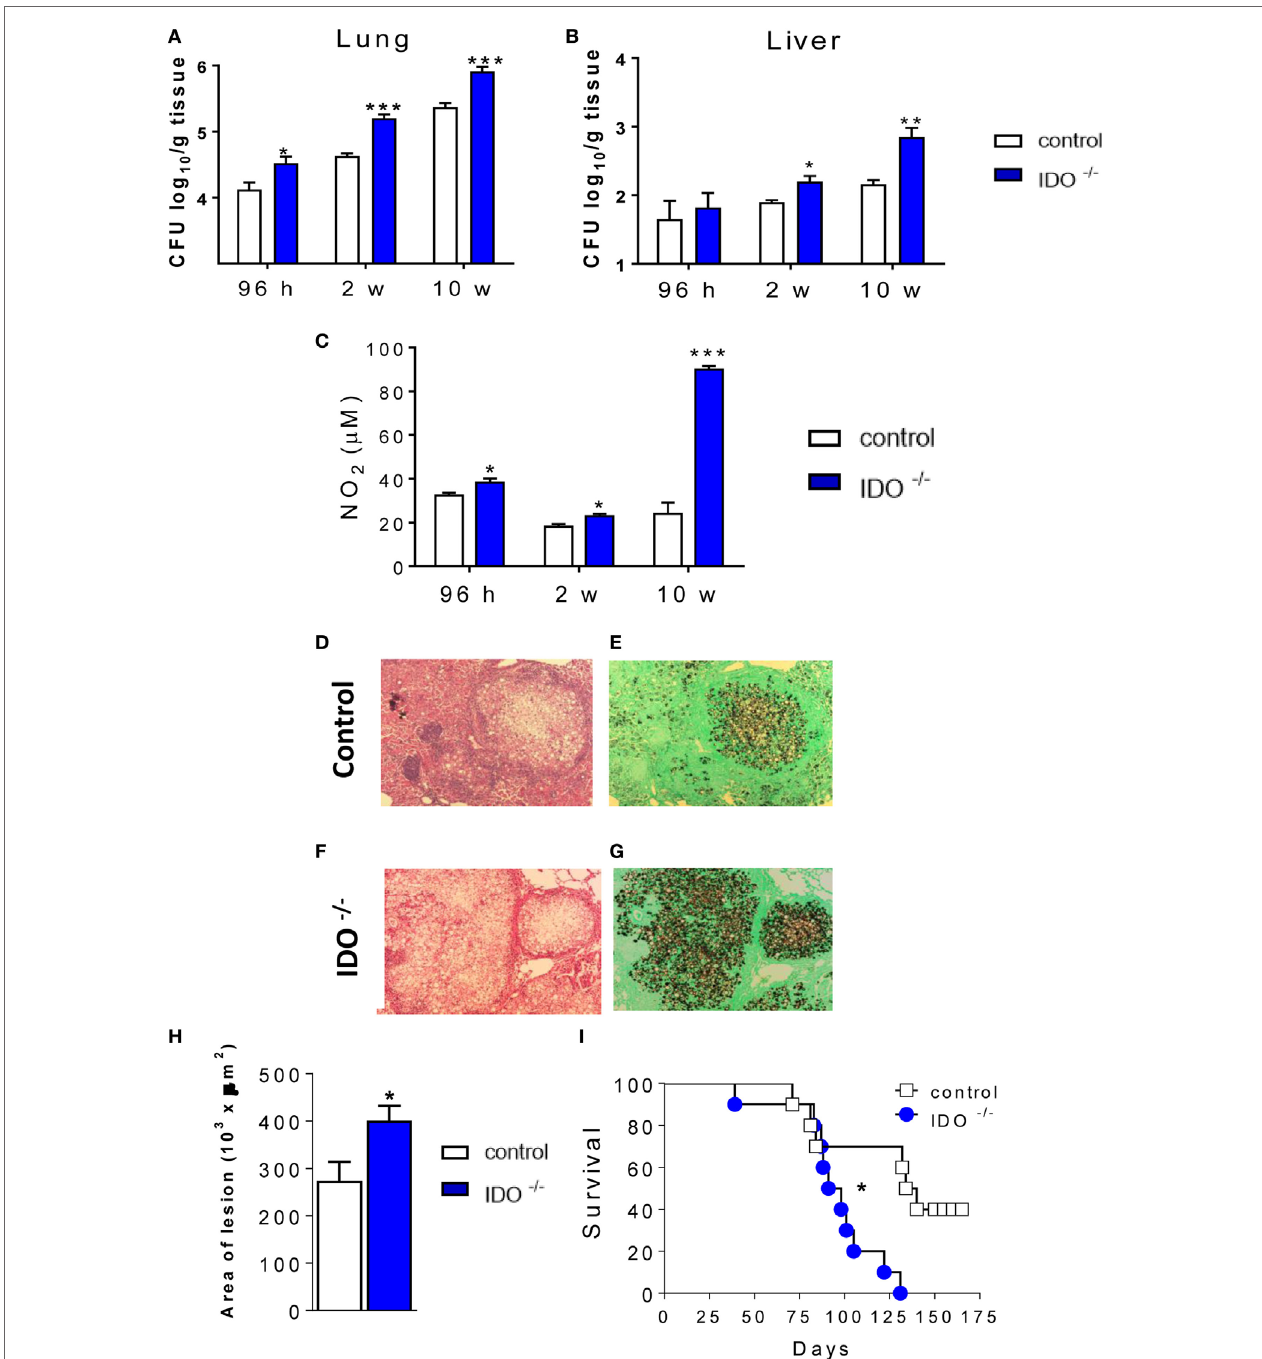
FigUre 1 | Indoleamine 2,3 dioxygenase-1 (IDO1) controls fungal loads, tissue pathology, and mortality rates. Groups of IDO1 − / − and wild-type (WT) C57Bl/6 mice were infected i.t. with 1 × 10 6 of Paracoccidioides brasiliensis yeasts. The colony-forming units (CFUs) from lungs (a) and liver (B) were determined 96 h, 2, and 8 weeks after infection. The bars represent means ± SEs of the mean (SEM) of log 10 CFU counts obtained from groups of 4 to 5 mice. (c) Supernatants of lung homogenates were obtained from infected mice ( n = 4–5/time point) and used to determine the levels of nitrite by the Griess reagent. (D–g) Photomicrographs of lung lesions of WT control mice (D,e) and IDO1 − / − mice (F,g) at week 10 of infection. Lesions were stained with hematoxylin-eosin (left panels) and Grocott (right panels). (h) Morphometrical analysis of lung lesions. The areas of lesions were measured (in square micrometers) in 10 microscopic fields per slide in five mice per group and results expressed as the mean ± SEM of total area of lesions for each mouse. (i) Survival curves of WT and IDO1 − / − infected mice ( n = 10) were determined in a period of 175 days. Data represent the means ± SEM and are representative of two independent experiments with equivalent results (* p < 0.05; ** p < 0.01, and *** p <